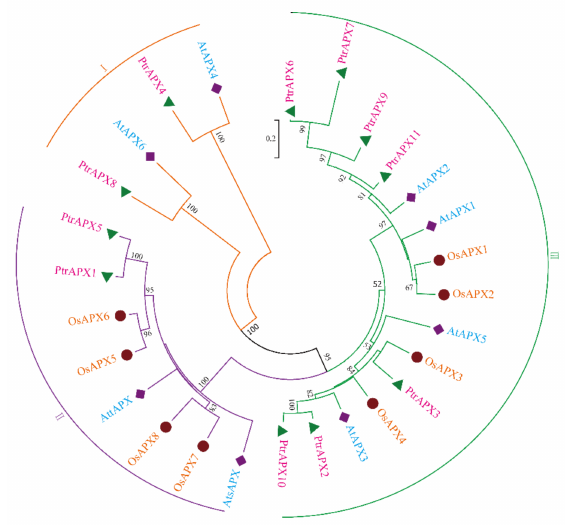
Figure 1. Phylogenetic analysis of APX proteins from Populus trichocarpa , Arabidopsis thaliana , and Oryza sativa. A multiple alignment of the full-length amino acid sequences was generated using Clustal X 2.0. The unrooted phylogenetic tree was constructed using the neighbor-joining method with 1000 bootstrap replicates using MEGA 7.0. Different species are represented by different colors. The APX proteins are classified into three clades (I, II, and III) based on their subcellular localization.